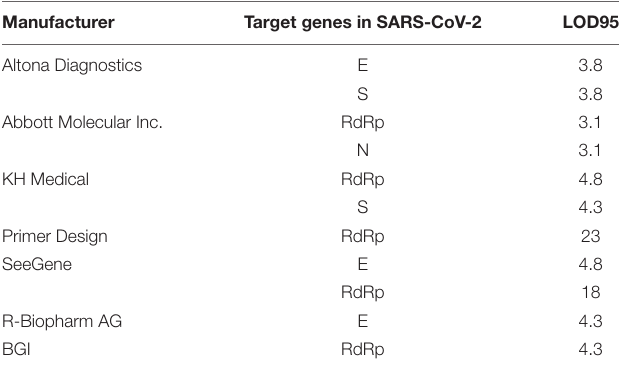
TABLE 2 | Comparison between RT-PCR based representative molecular diagnostic assays approved for diagnosis of COVID-19 (Kasteren et al.,